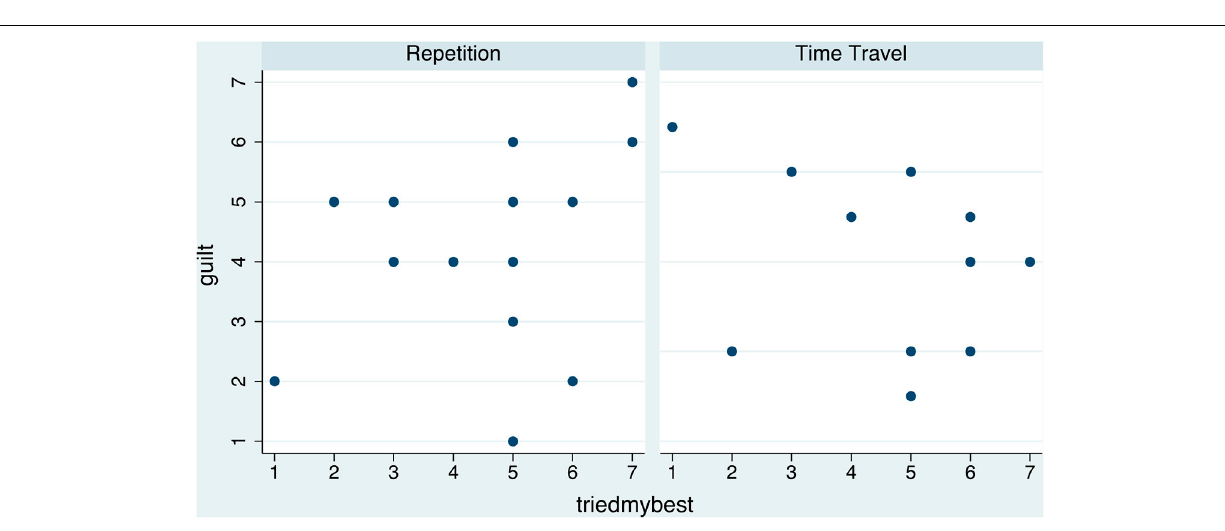
FIGURE 5 | Scatter diagram of guilt by triedmybest for each of the two Conditions (Repetition and Time